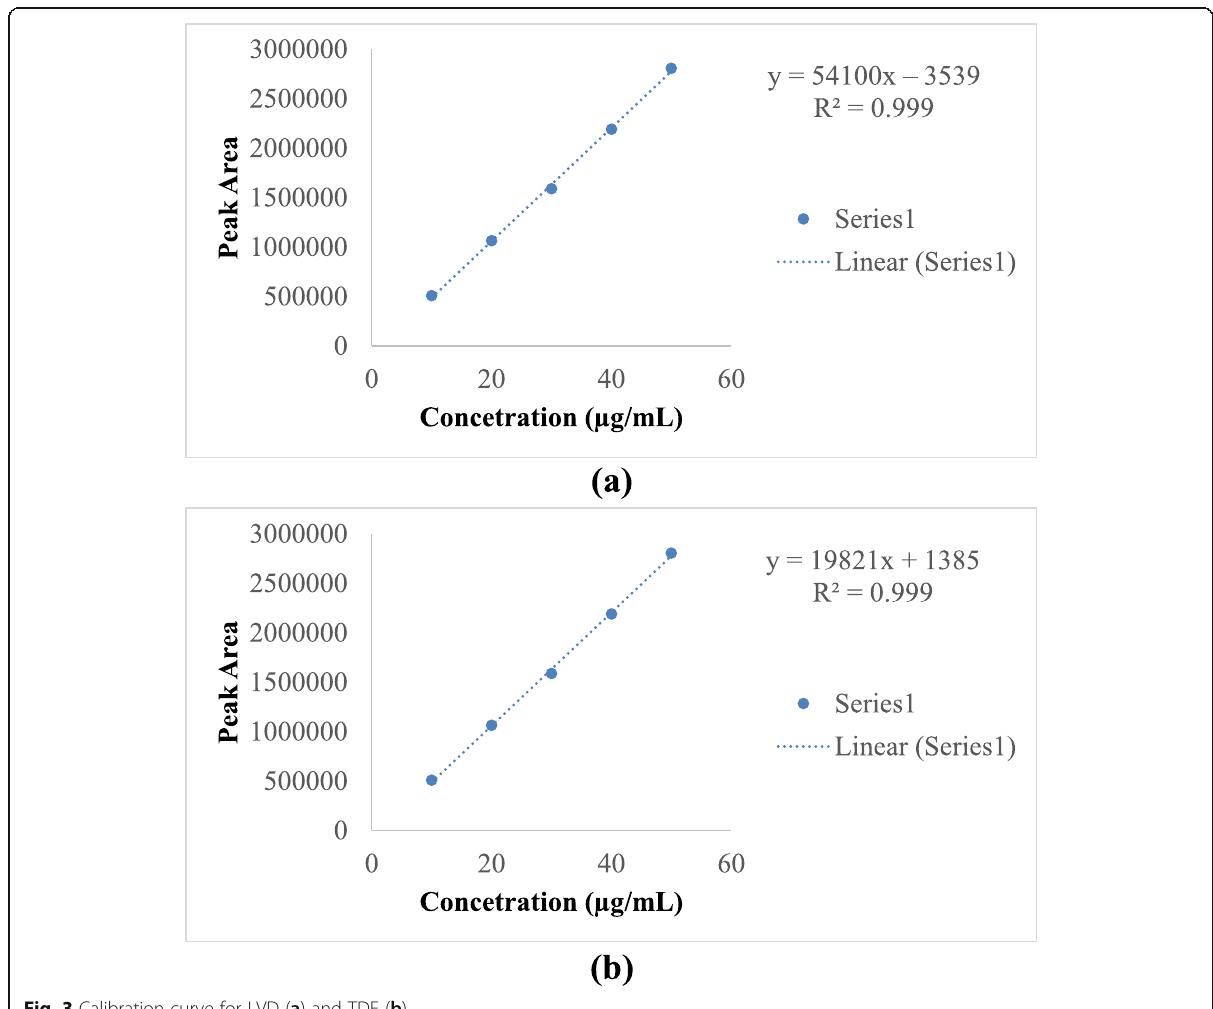
Fig. 3 Calibration curve for LVD ( a ) and TDF ( b